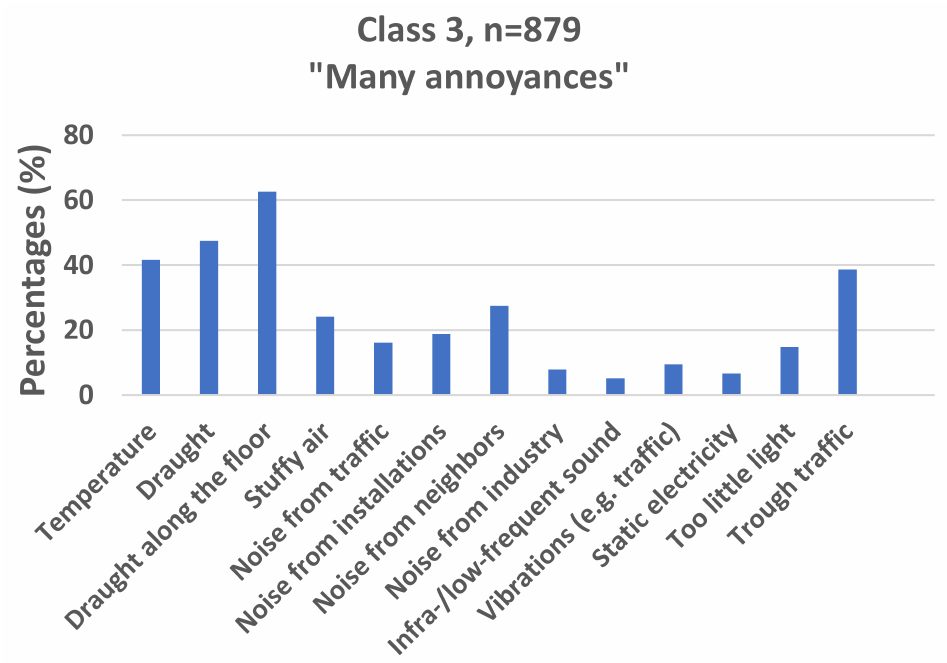
Figure 4. Predicted probabilities for levels of annoyances in homes, and nearness to a road with through traffic from three classes (n = 16,688). Class 1 “Very few annoyances”, Class 2 “Moderate annoyances”, and Class 3 “Many annoyances”.